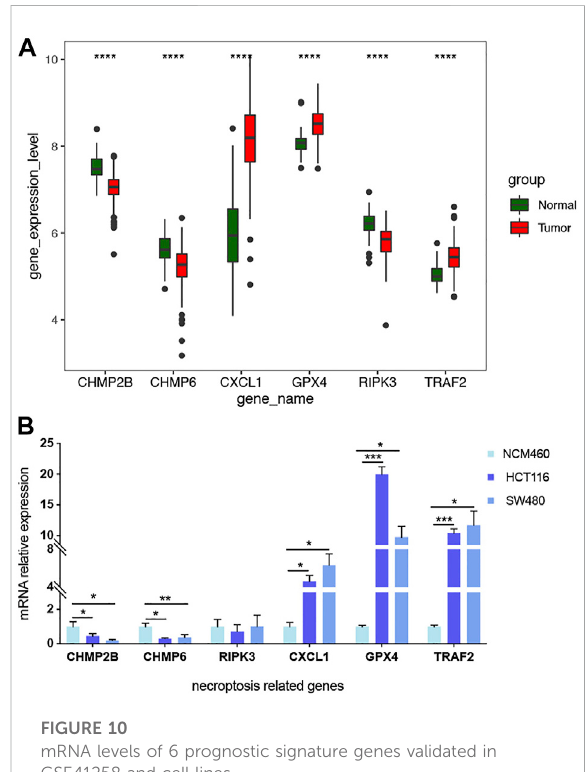
FIGURE 10 mRNA levels of 6 prognostic signature genes validated in GSE41258 and cell